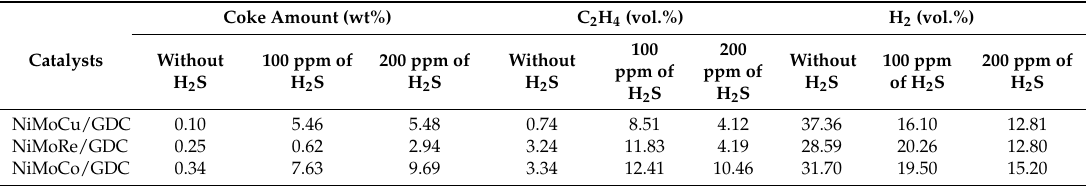
Table 2. Coke amount over catalysts after reaction in presence of H2S, measured by TG-DSC analysis at 800 ◦